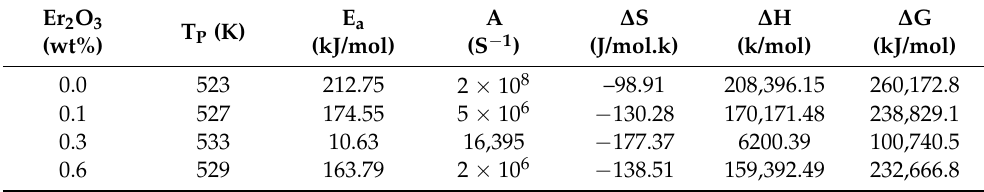
Table 1. The thermal parameters for PVC/PVP doped with different Er 2 O 3 concentrations.